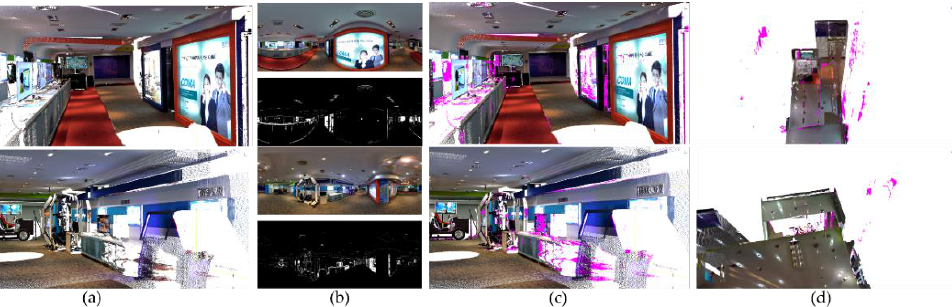
Figure 8. Noise detection results on individual sensor data. ( a ) Original point-cloud view; ( b ) RGB image from the LiDAR sensor and the 2D result image obtained by our method; ( c ) detected noise region (the purple part of the figure); ( d ) noise region from another view.